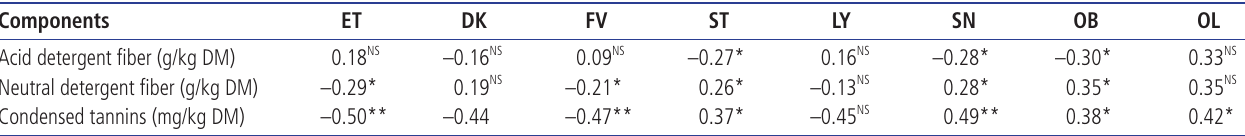
Table 5. Pearson’s correlation coefficients of behavioral activities of finishing pigs against condensed tannins and fiber of Vachellia tortilis leaf meal Components